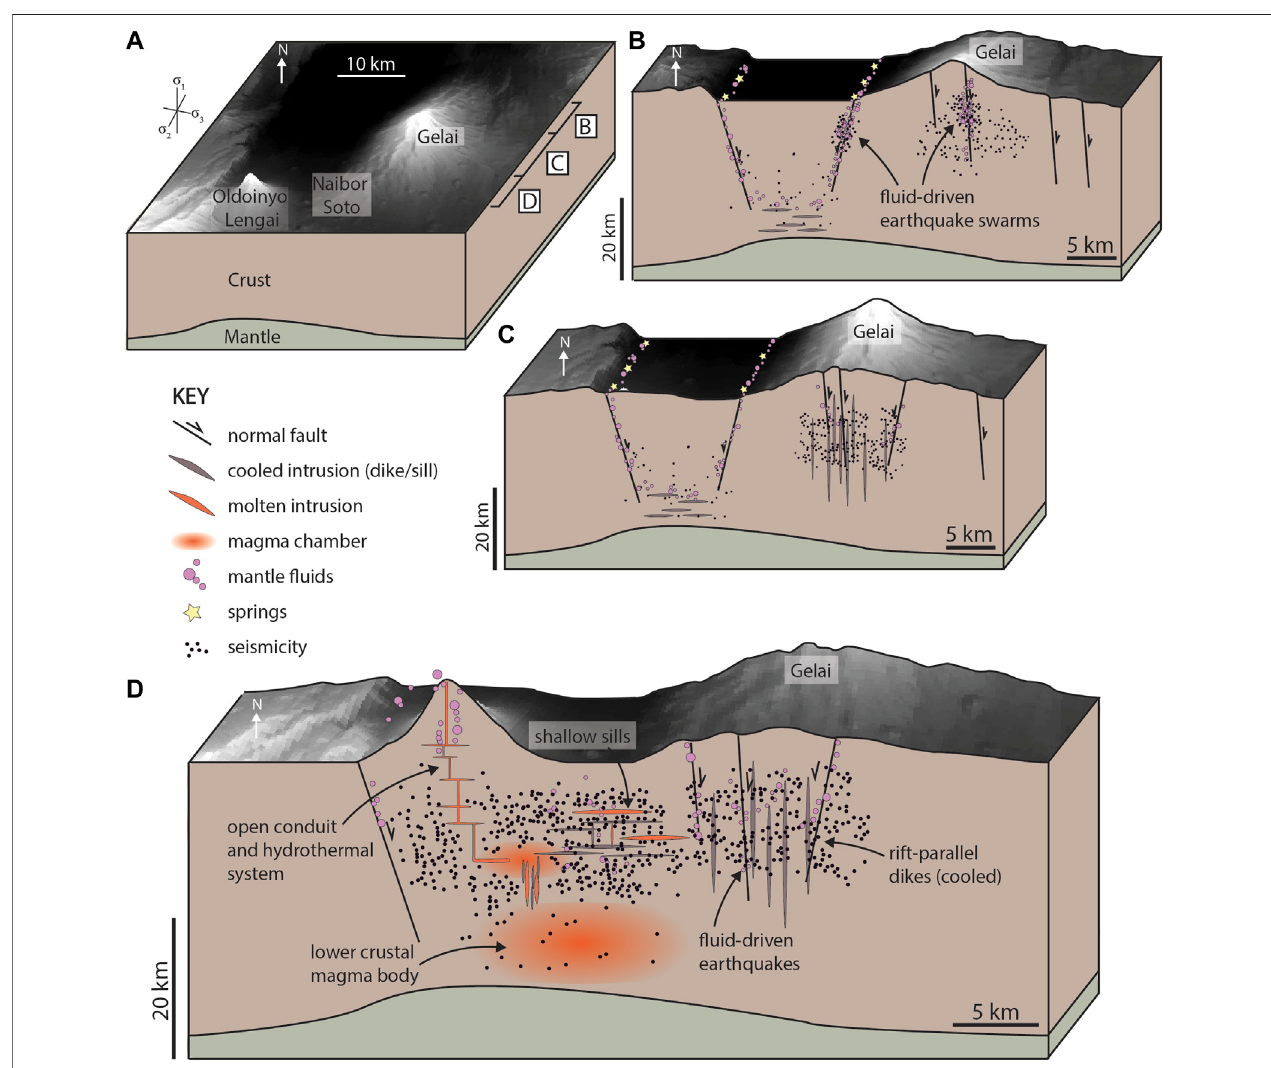
FIGURE 13 | Idealized conceptual illustration of magmatic- fl uid-tectonic interactions associated with the volcanic plumbing system of the south Natron basin. The structureoftheplumbingsystemsisbasedondataandinterpretationspresentedinthecurrentstudy,aswellaspreviousseismicityandgeophysicalstudiesbyRoecker etal.(2017)andWeinsteinetal.(2017).CrustalthicknessesarebroadlybasedonPlasmanetal.(2017)andsurfacetopographyisfromthe90 mSRTMDEMdataset. (A) Surface topography and general crustal structure of the south Natron basin, highlighting the position of the key volcanic features. Letters refer to the presented crustalsectionsin (B – D) . (B) Generaldistributionofseismicityatthenorthernendoftheseismicnetwork.DeepseismicityoccursbelowLakeNatron,withseismicswarm behavior associated with fl uid overpressures and fl uid migration through the crust. Helium isotope data of dissolved spring volatiles and carbon isotopes of diffusely degassing CO 2 support mantle fl uid fl ow through these fault systems (Lee et al., 2016, Lee et al., 2017; Muirhead et al., 2020). (C) General distribution of seismicity throughcentralregionsoftheseismicnetwork.SeismicitypatternsgenerallyfollowthoseinBandsupport fl uid-drivenearthquakes,althoughnospeci fi cseismicswarms have been identi fi ed. Cooled dike intrusions represent regions of past magmatic rifting, although no signi fi cant melt or active diking is inferred below Gelai volcano currently. (D) Generaldistributionofseismicitythroughoutthesouthernendoftheseismicnetwork,withdeformationpatternsstronglyin fl uencedbythepresenceofmelt and fl uids.TheinfrequentoccurrenceofseismicityinthelowercrustbelowtheNaiborSotovolcanic fi eldsupportthepresenceoflowercrustalmagmabodies,consistent with the crustal velocity structure presented by Roecker et al. (2017). Distinct seismic gaps below these volcanic systems represent vertical zones of partial melt and/or thermally altered regions, and represent possible connections between partial melt bodies at different crustal depths (Weinstein et al., 2017). Melt bodies and topographicloadsimposelocalstressperturbations(Olivaetal.,2019b)indicatedbyvariationsinfaultplanesolutionsobservedinthissystem.Persistentlowmagnitude seismicity throughout the region supports a model of earthquake activity driven by the percolation of melt and magmatic volatiles, consistent with full moment tensor analyses by Oliva et al. (2019a) who found various non-double couple earthquake source mechanisms.